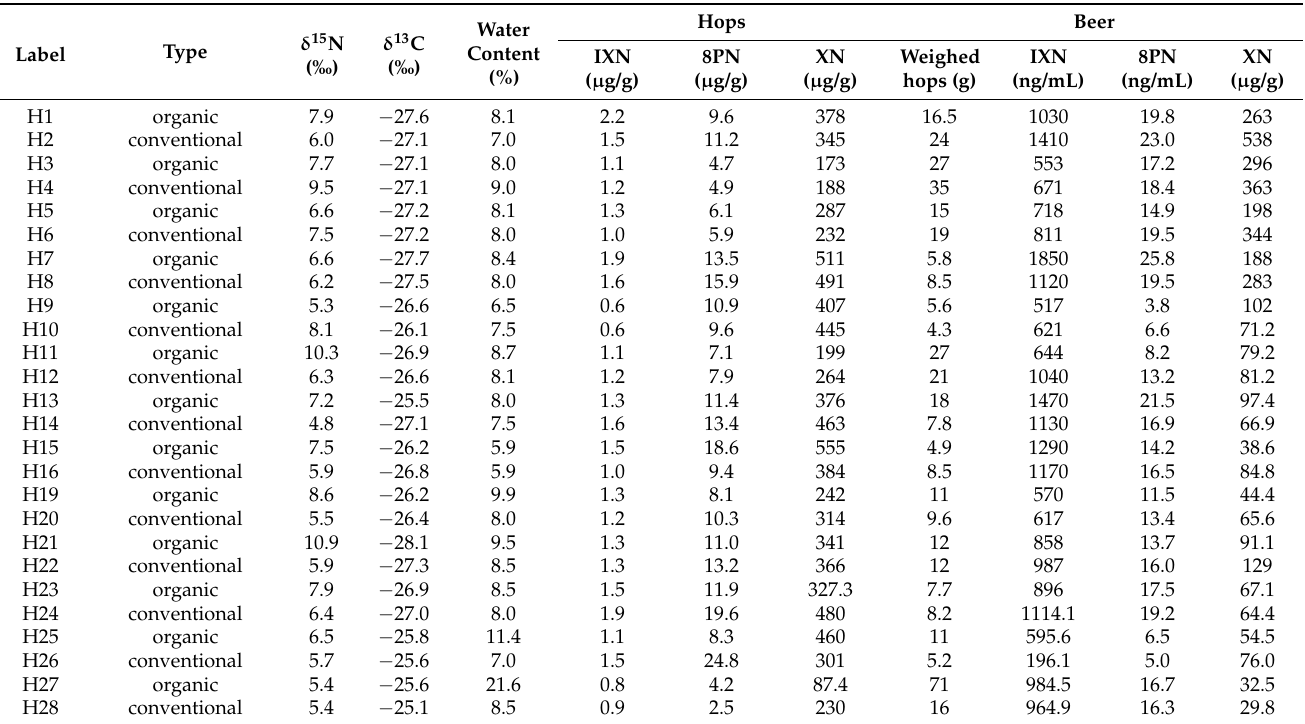
Table 1. Stable isotope data and results of xanthohumol (XN), isoxanthohumol (IXN) and 8-prenylnaringenin (8PN) analysis of hop samples and in-house beer ( n =